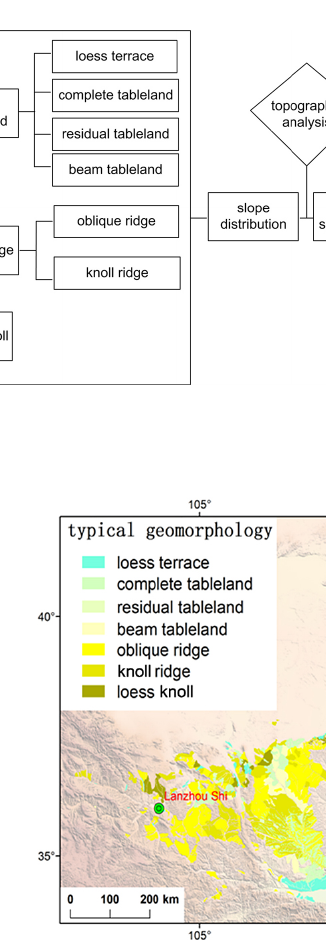
Figure 2. Typical loess geomorphology distribution in the Loess